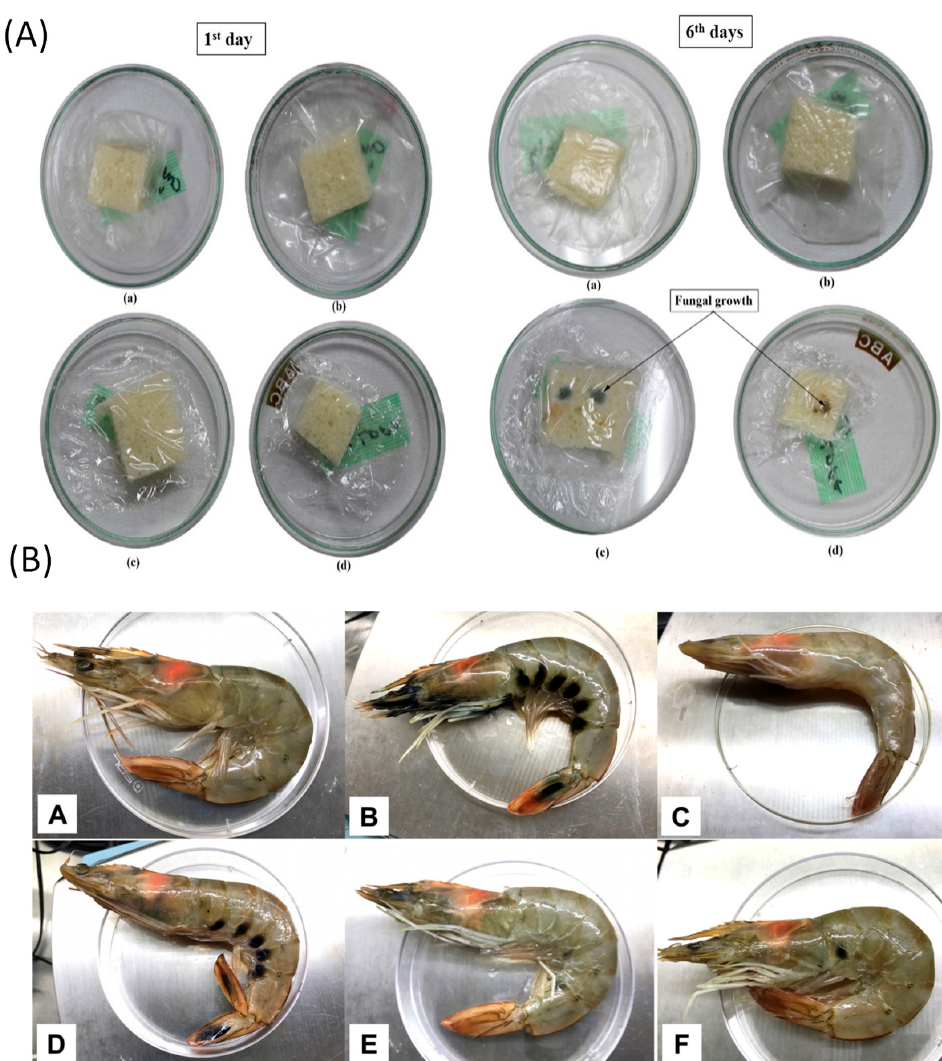
Figure 4. The packaging test of GSE included corn starch/chitosan-based film and alginate/chitosan- based coating. ( A ) Bread sample packed with (a,b) corn starch/chitosan/nanoclay/1.5%GSE films (c,d) low-density polyethylene films. (Reproduced from Jha 2020 [26]), ( B ) Appearance of shrimp during packaging test. Fresh shrimp for untreated control shrimp before and after storage (A–C) and coated with functional film before and after storage (D–F) (Reproduced from Kim et al., 2018 [79]). Baek et al. (2021) [76] also developed an alginic acid edible coating containing GSE for shrimp preservation. Compared to the alginate-coated treatment alone, the